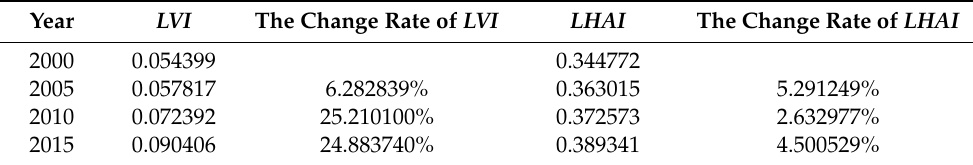
Table 4. LVI / LHAI and their change rates at province